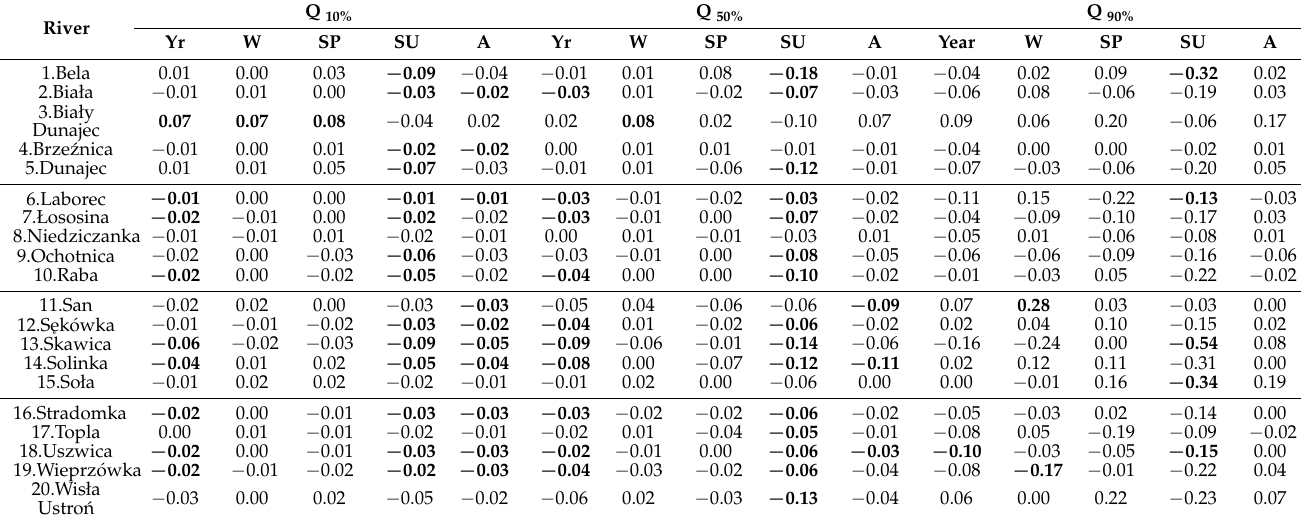
Table 4. Theil–Sen estimator (mm/10 years) for total daily runoff ( Q ) percentiles obtained for the entire year (Yr), winter (W), spring (SP), summer (SU), and autumn (A); statistically significant trends are marked in